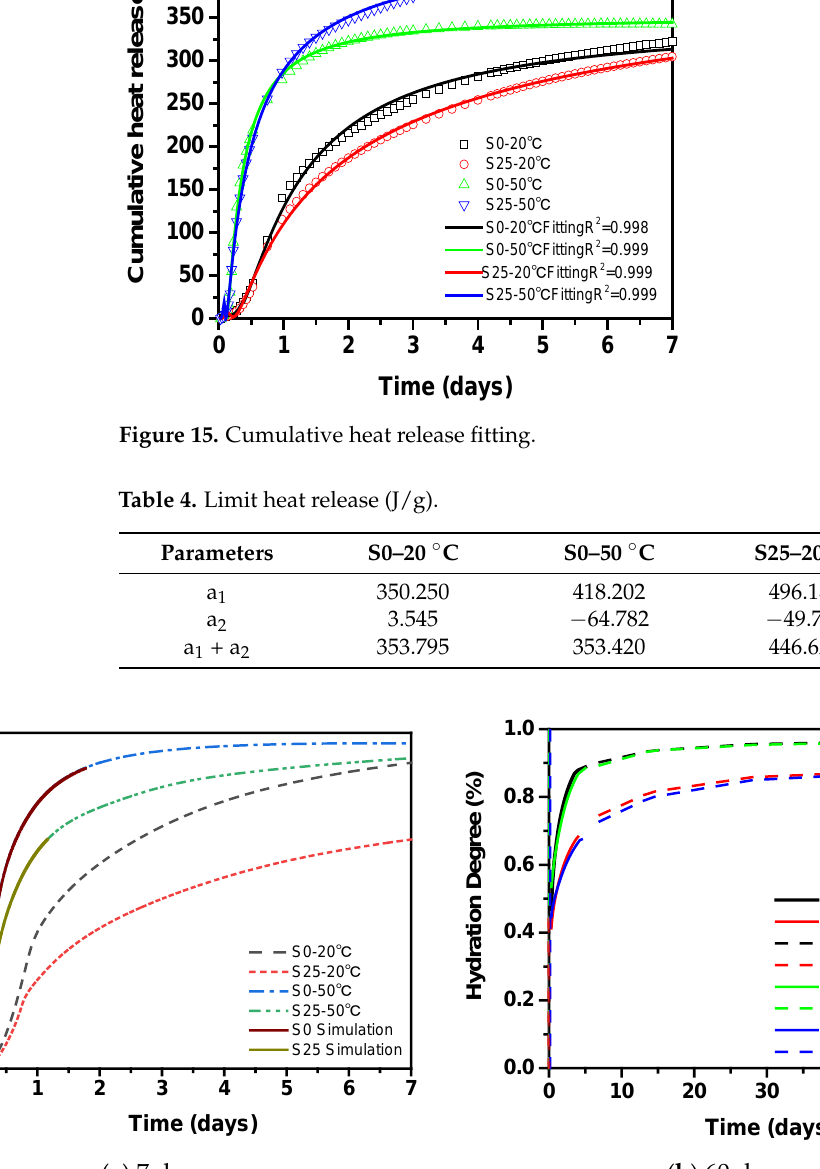
Figure 17. Temperature change inside steam-cured concrete. 4.2. Relationship between Shrinkage and Relative Humidity of Steam-Cured Concrete after Stream Curing In this section, the change of relative humidity in concrete is used as the internal cause, and an integrated model of autogenous shrinkage and total shrinkage of steam-cured concrete is established based on elastic modulus, hydration degree and pore diameter. Since the model defaults to the zero time as the starting value, the calculated value of the model should be compared with the test results after demould to verify the applicability of the model. According to the self-consistent method, the shrinkage strain caused by the internal tensile stress 𝜎𝜎 𝑐𝑐𝑎𝑎𝑐𝑐 is shown in Equation (9) [61,62]: